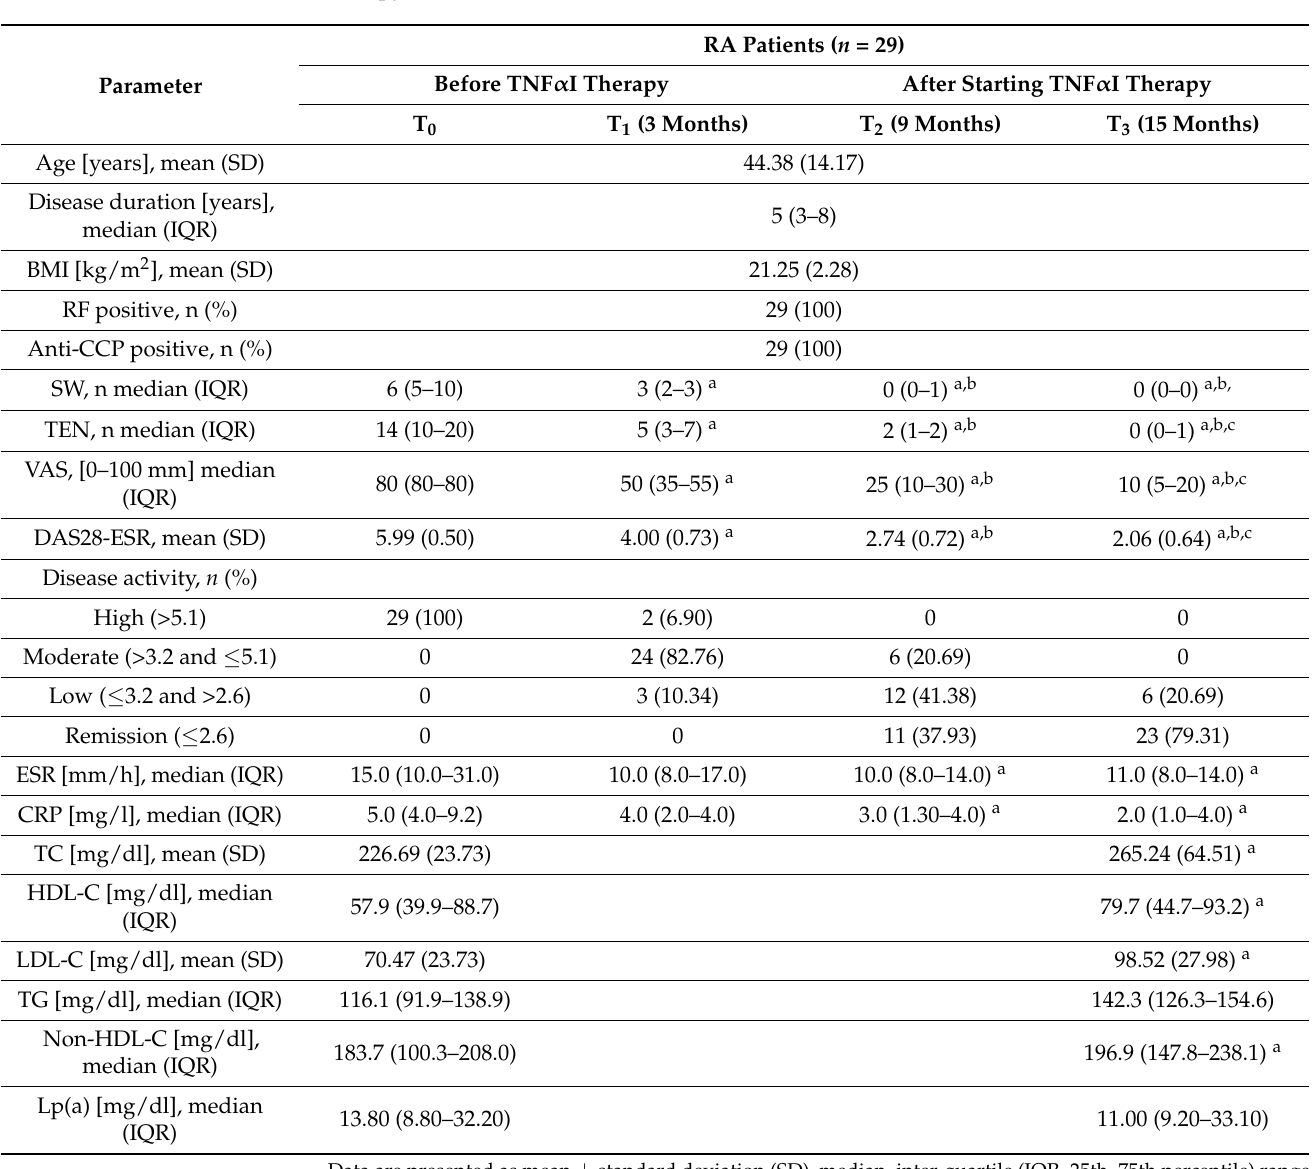
Table 1. Alterations to biochemical, clinical and functional measures during 15-month anti-TNF- α